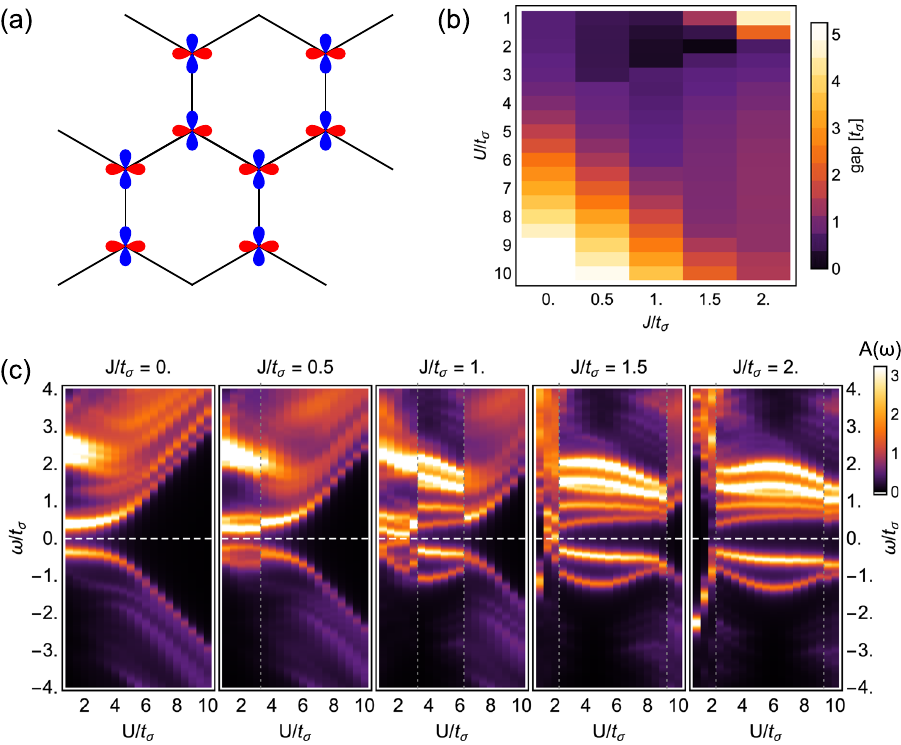
Fig. 3 Charge gap and correlations for twisted bilayer MoS 2 at vanishing temperature. a depicts the 16-orbital cluster geometry employed for exact diagonalization of the Hubbard-Kanamori Hamiltonian. b depicts the charge gap as a function of Hubbard U and Hund ’ s exchange J interactions, calculated for the 16-orbital cluster and extracted from ( c ) the local density of states, which is readily accessible via scanning tunnelling microscopy. A well-de fi ned charge gap develops beyond U / t σ ~ 4 at small J that scales linearly with the Hubbard interaction U . Vertical gray dotted lines indicate phase transitions to charge-ordered states at large J / U , coinciding with a closing of the charge